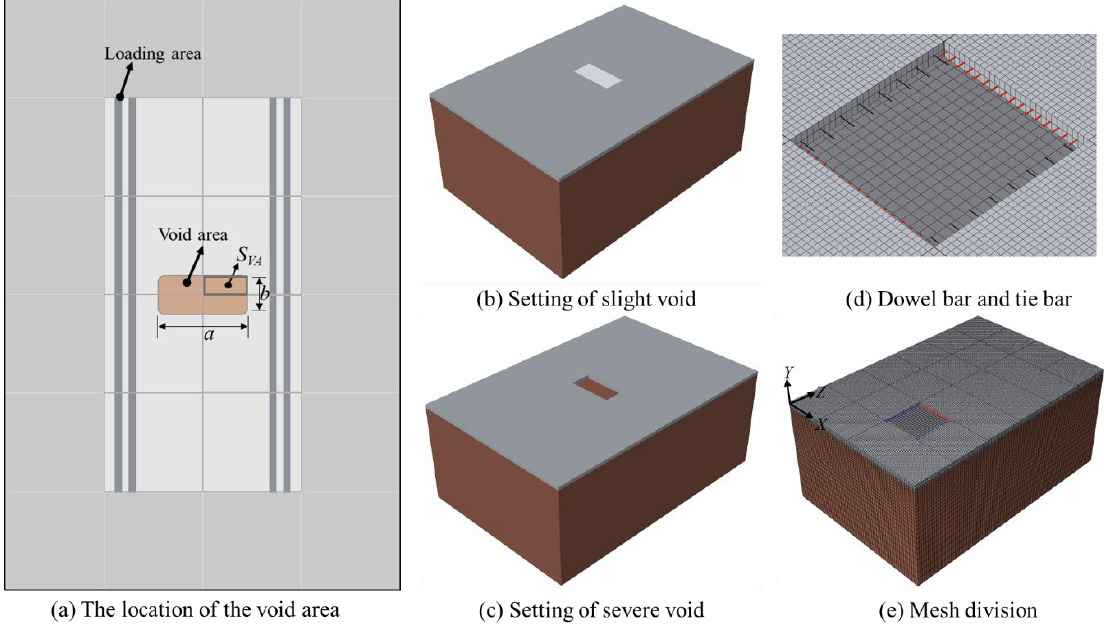
Figure 7. Void mode and mesh generation of